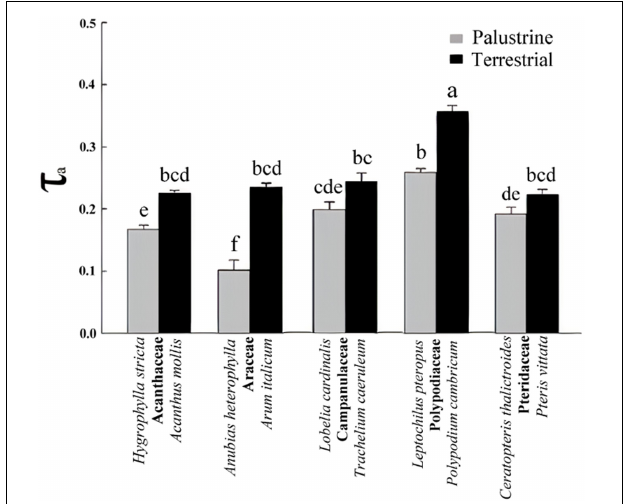
FIGURE 3 | Electron partitioning to the alternative pathway ( τ a ) in all palustrine and terrestrial species tested in this study. Values are the mean of six to eight measurements obtained from 4 to 6 plants per species. Different letters indicate significant differences with a p -value < 0.05 determined by a post hoc Tukey–Kramer’s